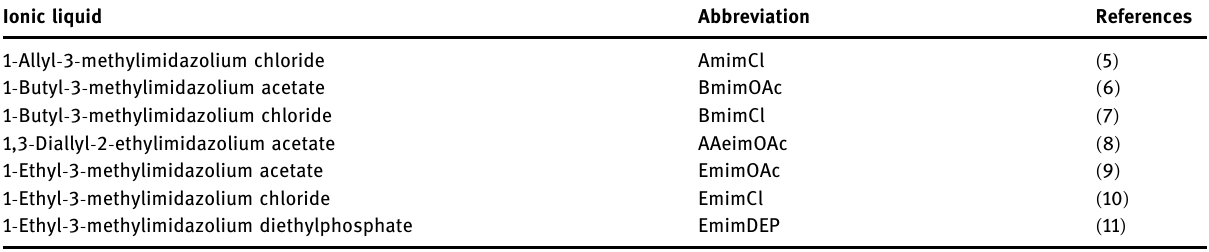
Table 1: Examples of imidazolium - based ionic liquids used in the dissolution of cellulose Ionic liquid